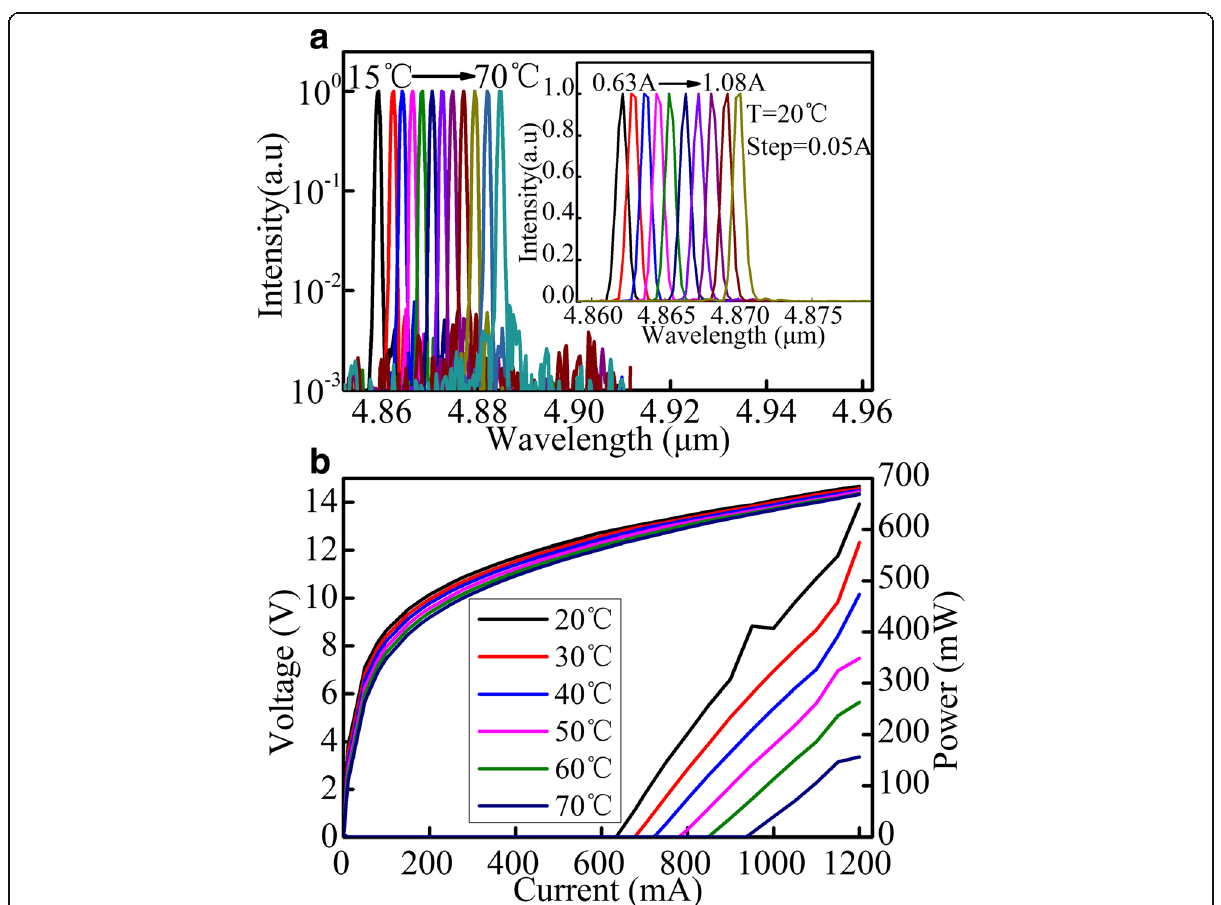
Fig. 5 a Single-mode CW emission spectra of a sampled grating DFB QCL with the cavity length of 4mm at currents of about 1.1 × I th for different heat sink temperatures of 15 – 70°C. The inset shows CW emission spectra at different injection currents from 0.63 to 1.08 A with a step of 0.05 A at 20° C. b CW light – current – voltage (L – I – V) characteristics of sampled grating DFB QCL with the cavity length of 4mm at different